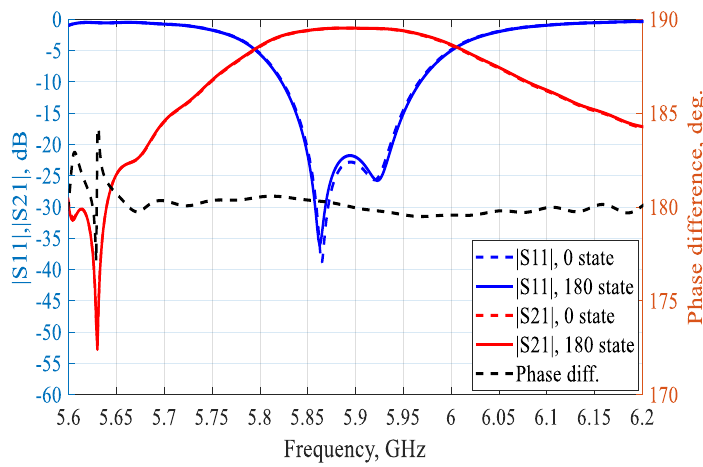
Figure 4. The simulated results of the unit cells scattering parameters modules for both p-i-n diodes states and phase difference.